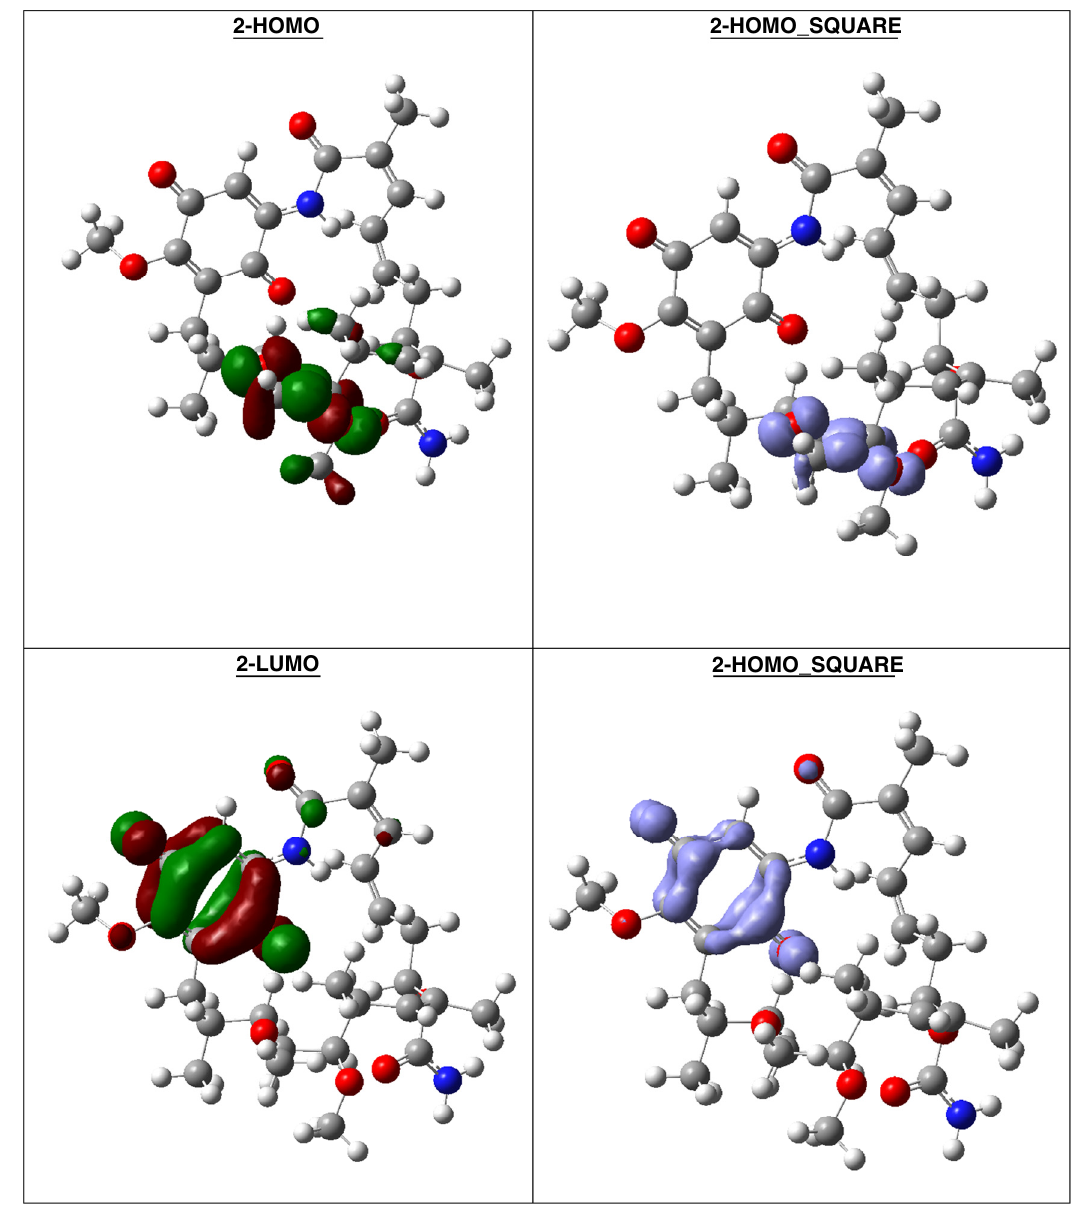
Figure 19. Frontier molecular orbitals HOMO, LUMO (isosurface 0.02), the Fukui Functions 2 k f HOMO − ≈ and 2 0.004), to reference compound 2.